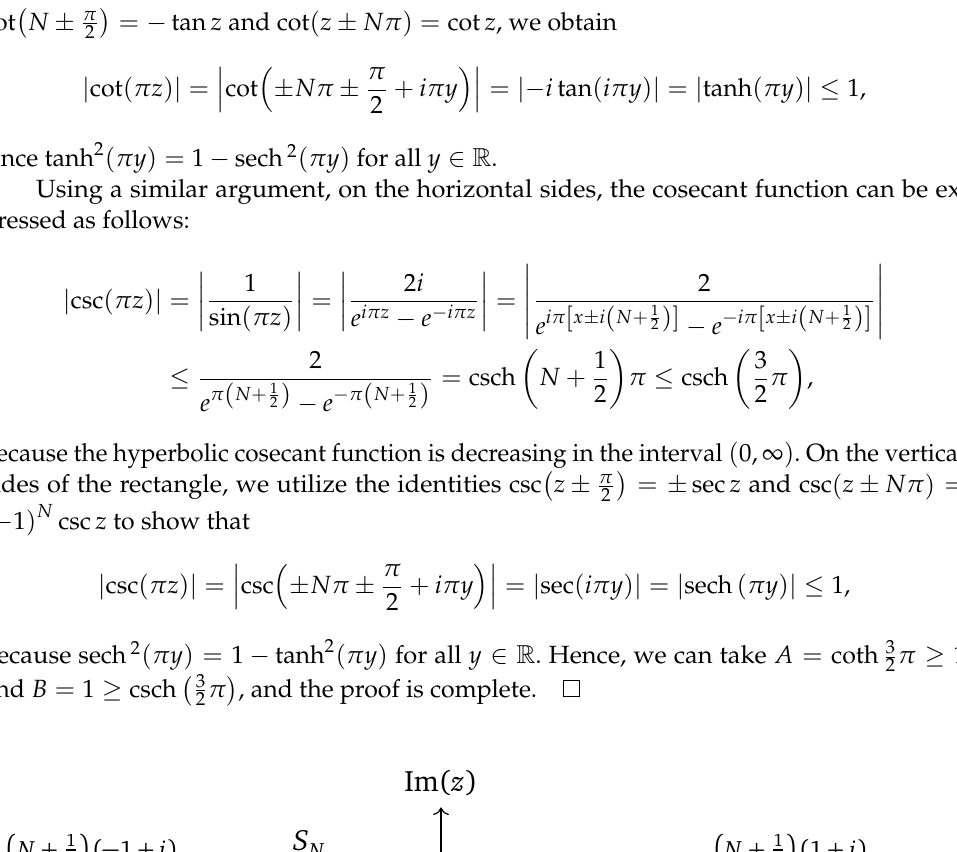
Figure 4: The square S